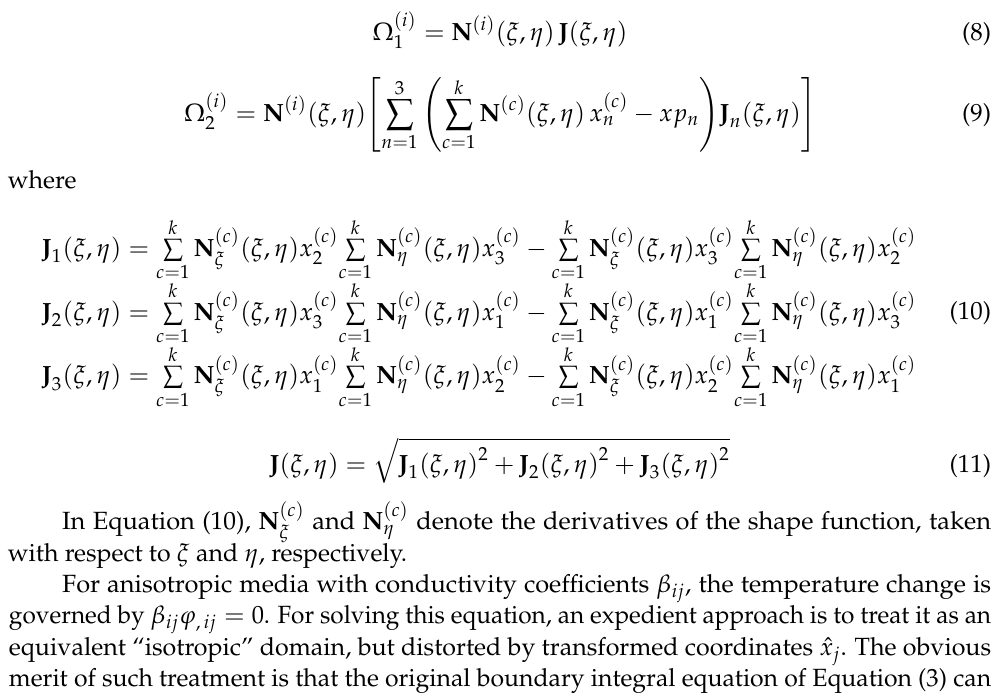
I and ( b ) K for a typical case. i i